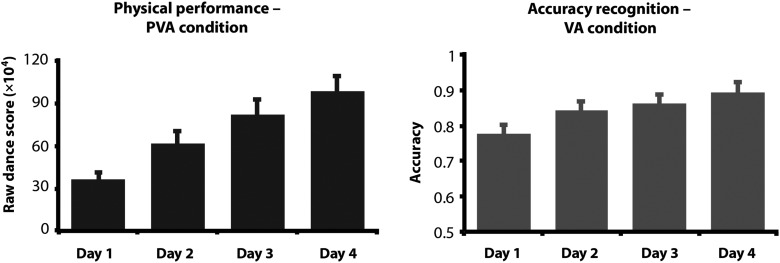
The left plot illustrates mean dance scores for the PVA trained sequences across training days. The right plot illustrates mean accuracy performance on the recognition task for the VA trained sequences. Error bars in both plots indicate the across-subject standard error of the mean.